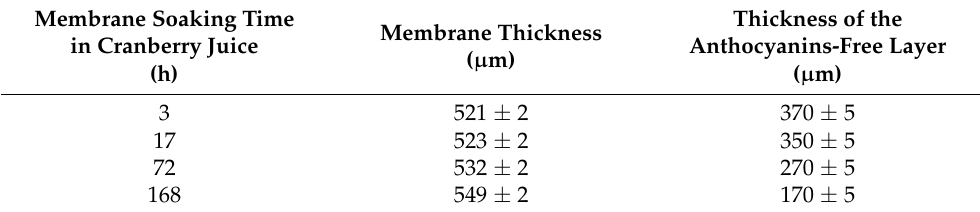
Figure 7. Optical images of the surfacesthe total concentration of anthocyanins and PACs in these solutions increased in the same sequence (left) and cross-sections (right) of MK-40 membrane coupons that were in contact with cranberry juice for 3, 17, 72, and 168 h. Before obtaining images, these coupons were placed for 2 h in a buffer solution at pH 3.6, 6.9, and 9.3. The dependence of cranberry juice pH (diluted 10 times) on its color is shown below the figure. The scale is 300 µm. Table 6. Evolution of the MK-40 membrane thickness and respective anthocyanin-free layer thickness in its cross-section, depending on the soaking duration in cranberry juice.